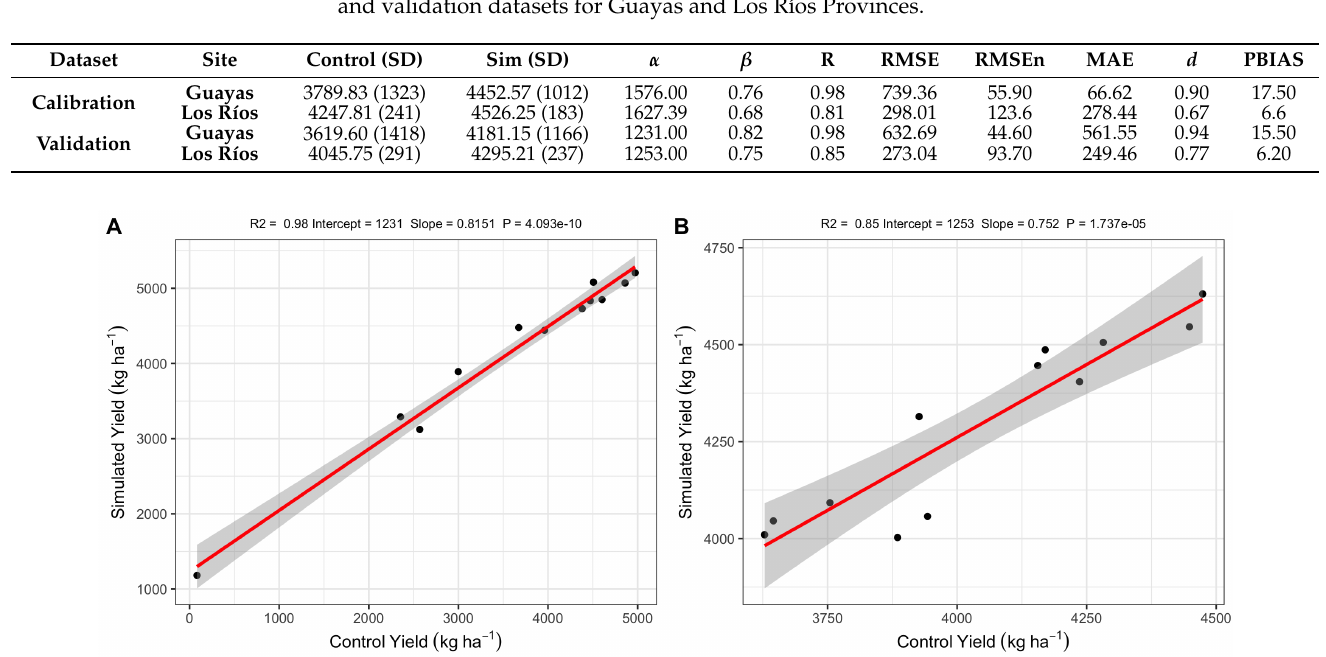
Figure 4. Correlations between yearly simulated and observed (control) total yields corresponding to the 1994–2005 validation data set for Guayas ( A ) and Los Ríos ( B ) Provinces. The red lines represent fitted linear regression lines, and the gray-shaded areas represent 95% confidence